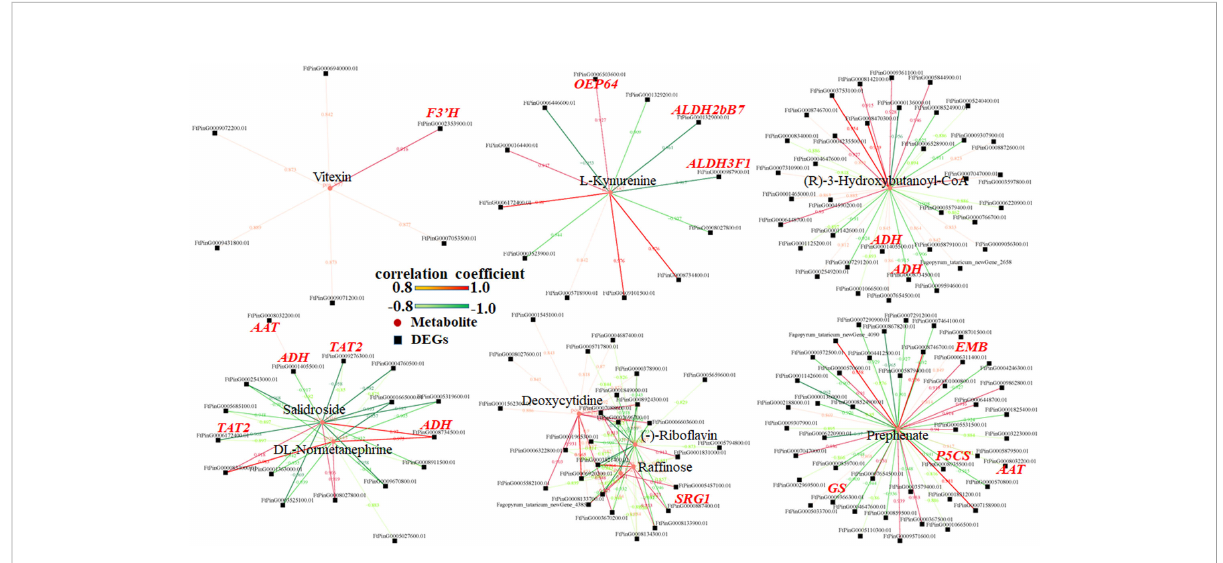
FIGURE 7 The correlation network diagram of DEGs and metabolites.